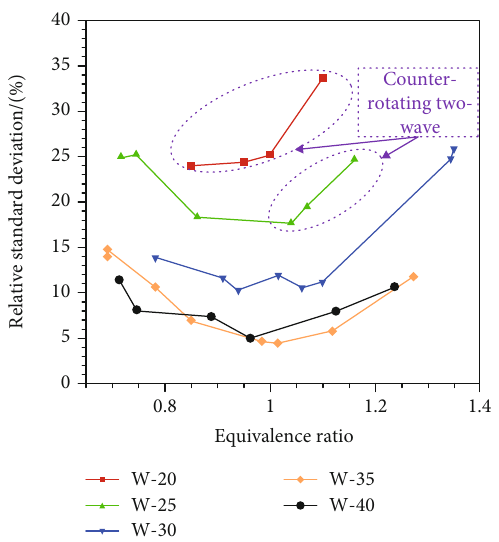
Figure 15: E ff ects of combustor width on P4 pressure in the combustor.